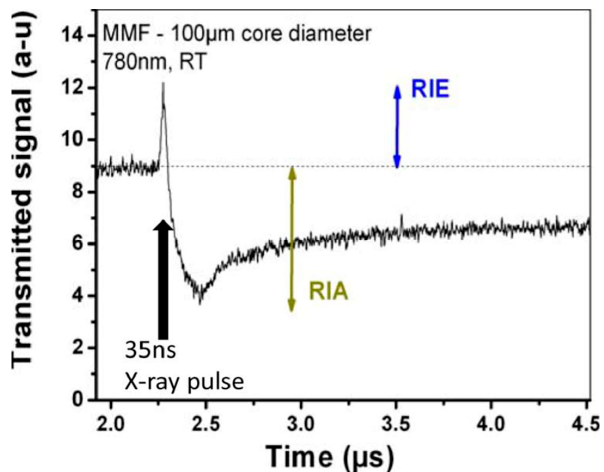
Figure 12. Radiation-induced emission and attenuation of a multimode fiber at 780 nm irradiated for 35 ns with 1 MeV X-rays [103].